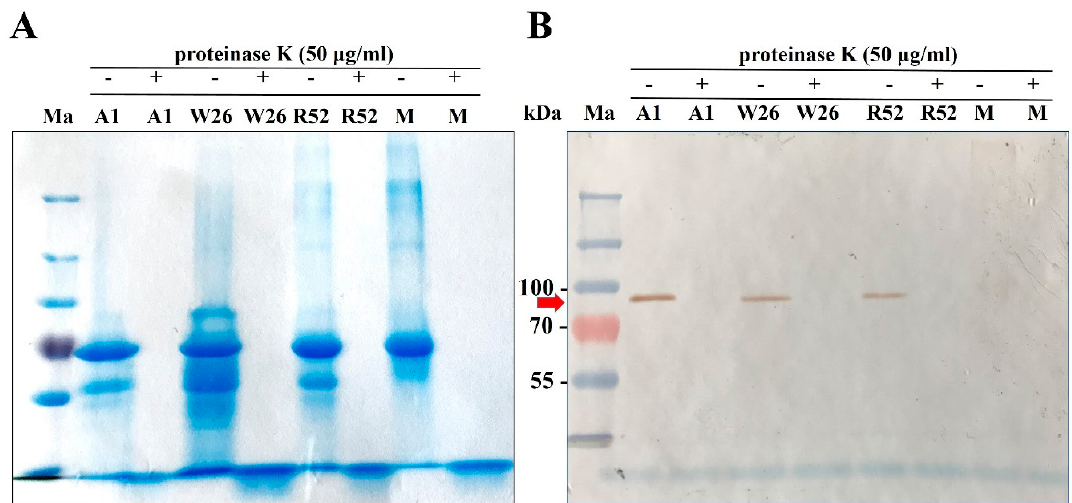
Figure 6. Protein profile of untreated and proteinase-K-treated selected blossom honey samples and manuka honey (M) and immunoblot analysis of glucose oxidase (GOX). Aliquots (15 μ L) of 50% (w/w) honey solution in MHB medium with or without proteinase K treatment were separated by SDS-PAGE. Gel was stained with Coomassie Brilliant Blue R-250 ( A ) or immunoblotted with a polyclonal antibody against GOX ( B ). Ma, protein prestained marker. Red arrow indicates GOX with a molecular weight of 84 kDa. After confirming the proteinase K inactivation e ff ect on GOX, antibacterial activities of